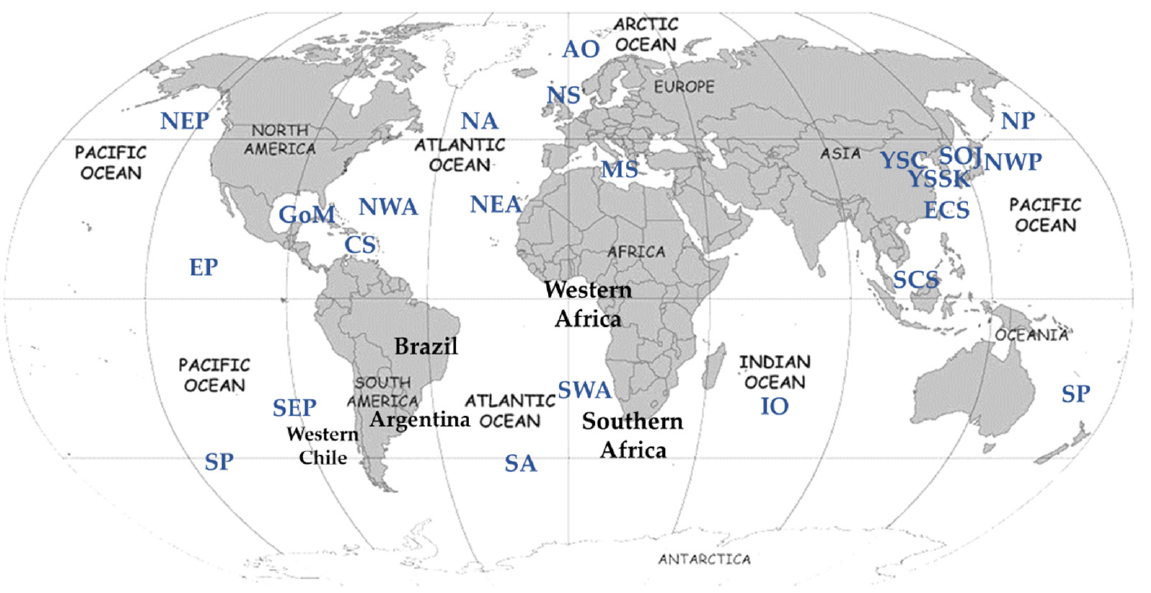
Figure 1. Map shows geographical locations of collection sites, adopted from the source of sequences in NCBI. Abbreviations are herein referred to as Arctic Ocean (AO), North Sea (NS), North Atlantic (NA), northeast Atlantic (NEA), northwestern Atlantic (NWA), Caribbean Sea (CS), Mediterranean Sea (MS), Gulf of Mexico (GoM), South Atlantic (SA), southwest Atlantic (SWA), North Pacific (NP), East Pacific (EP), northeast Pacific (NEP), northwest Pacific (NWP), southeast Pacific (SEP), Yellow Sea China (YSC), Yellow Sea South Korea (YSSK), East China Sea (ECS), South China Sea (SCS), Sea of Japan (SOJ), and Indian Ocean (IO).